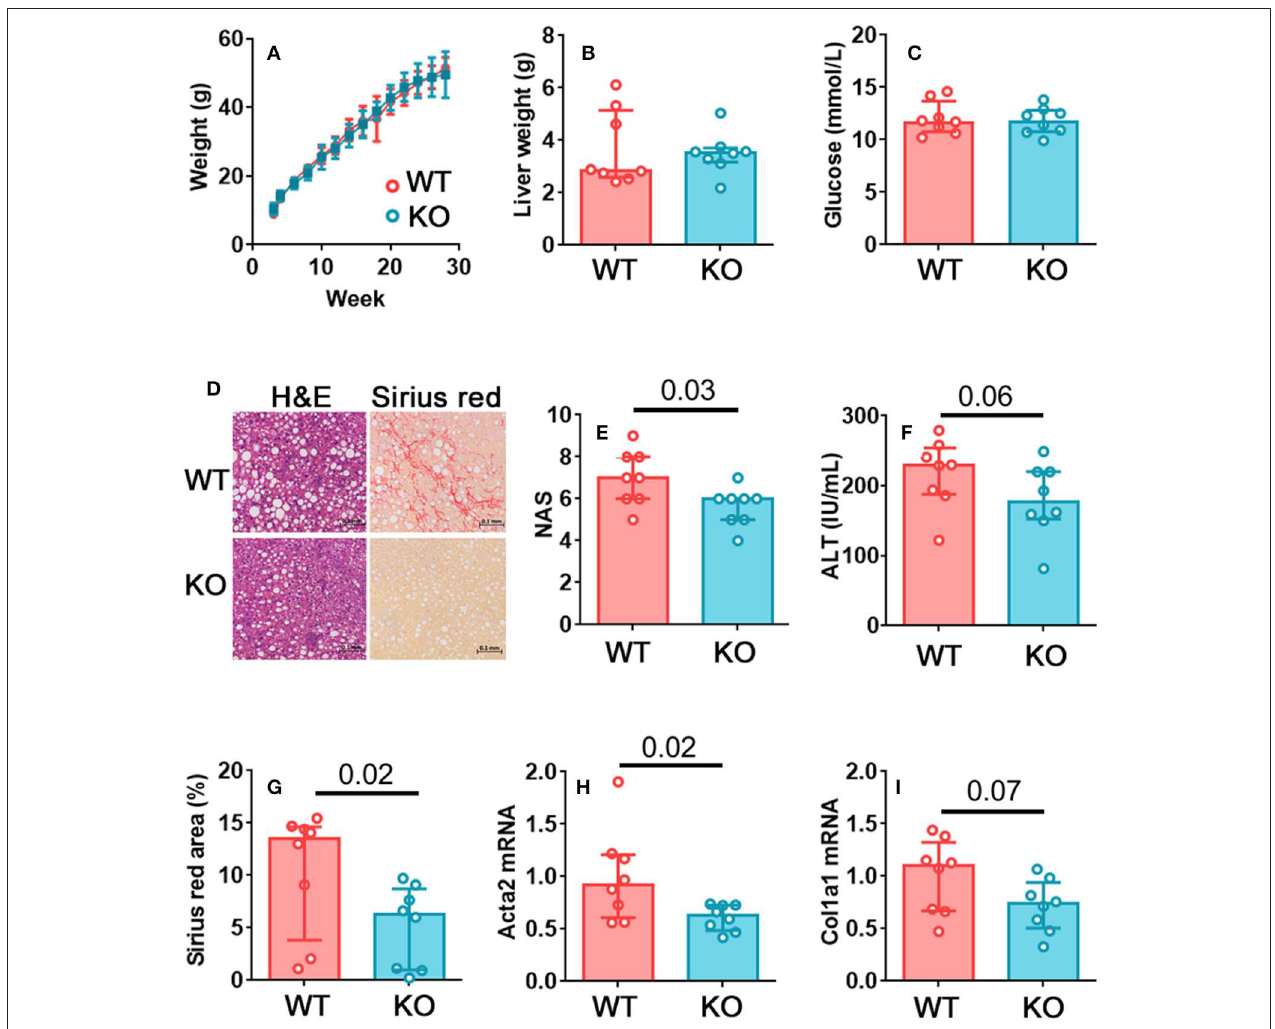
FIGURE 2 | Perforin-mediated killing promotes fibrosis in NAFLD. (A) Growth curves for wild type and perforin knockout mice on the obesogenic diet. (B) Liver weights for wild type and perforin knockout mice after 24 weeks on the obesogenic diet. (C) Plasma glucose levels. (D) Representative H&E and Picrosirius red staining in a wild type and a perforin knockout mouse. (E) Histological score in wild type and perforin knockout mouse livers, after 24 weeks on the obesogenic diet. (F) Plasma ALT levels. (G) Picrosirius red positive area in representative histological fields. (H,I) Acta2 and Col1a1 mRNA in livers of wild type and perforin knockout mice, after 24 weeks on the obesogenic diet. n = 8 mice per group; significance was determined using Mann Whitney U -Tests; medians and IQRs are